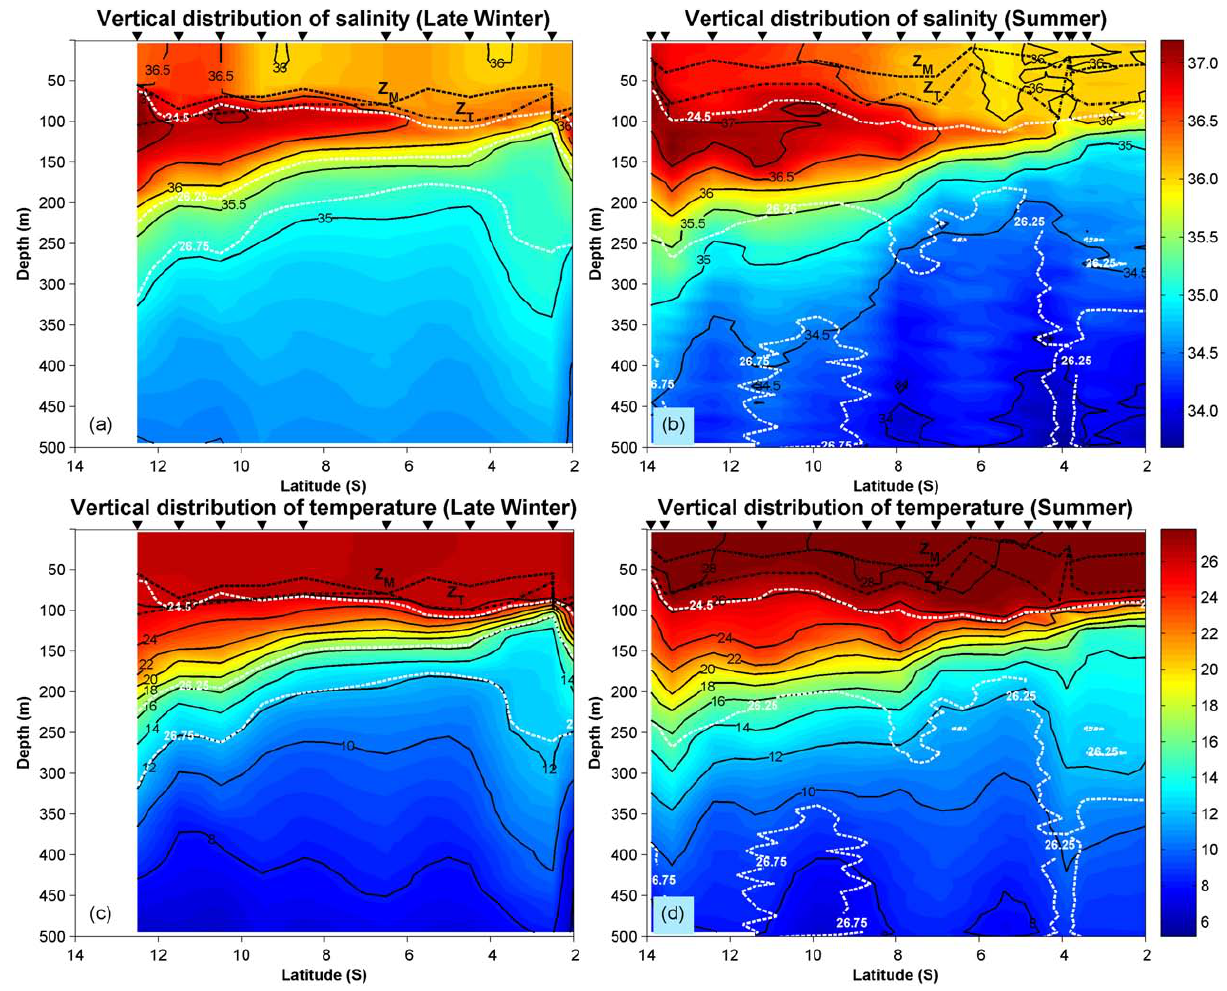
Fig. 3. Vertical salinity and temperature distributions (surface to 500m depth) along the transect, indicated by a dashed line (see Fig. 1), during REVIZEE cruises. Salinity parameter during: (a) late austral winter (August–October 1995); and (b) austral summer (January–April 1997). Temperature parameter during: (c) late austral winter (August–October 1995); and (d) austral summer (January–April 1997). The black dashed lines indicate depth of isothermal and mixed layers ( Z T and Z M ). Dashed white lines indicate depth of σ θ = 24 . 5, 26.25, 26.75 and 27.70. The location of the CTD casts is shown by the black inverted triangles. Similar Mercator results are presented from (e) to (h) , following the same parameters and seasons from the REVIZEE